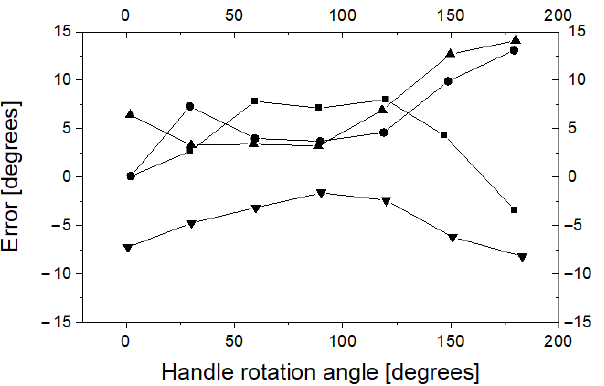
Figure 15. Angular differences (error) between readings D2 and reference frame R2. The different symbols correspond to four series of measurements.